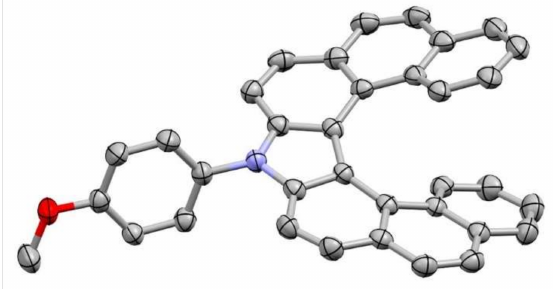
Figure 4. ORTEP drawing of ( M )- 5c with thermal ellipsoids at 50% probability. All hydrogen atoms and the crystal solvent molecule (CHCl 3 ) are omitted for clarity.